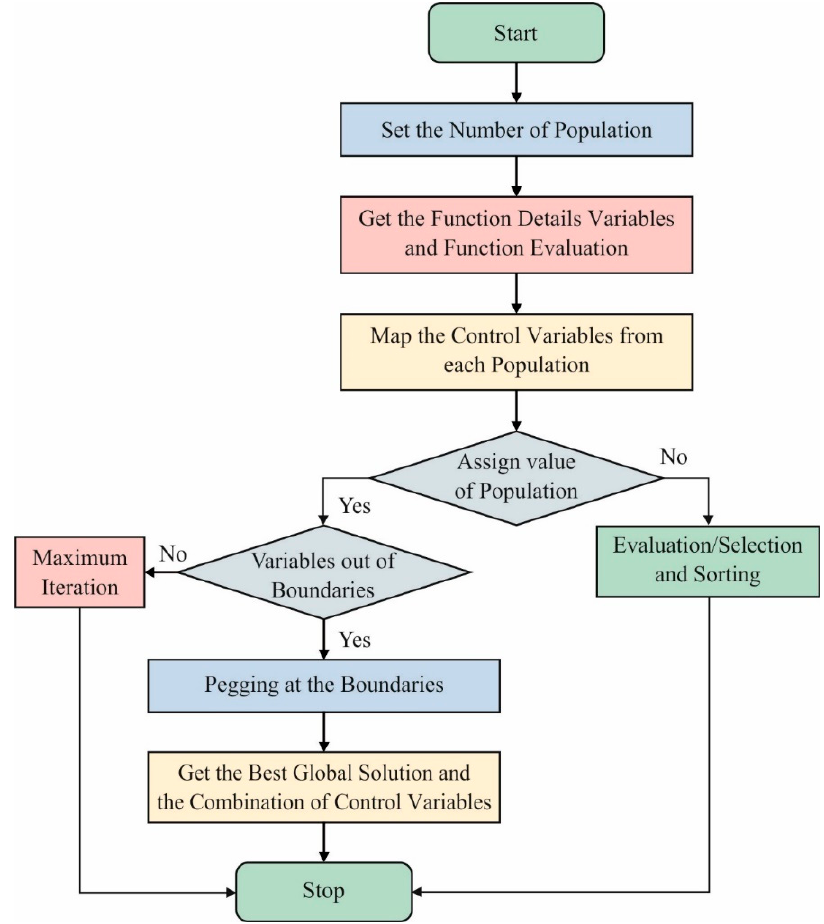
Figure 2. BMO Flowchart.